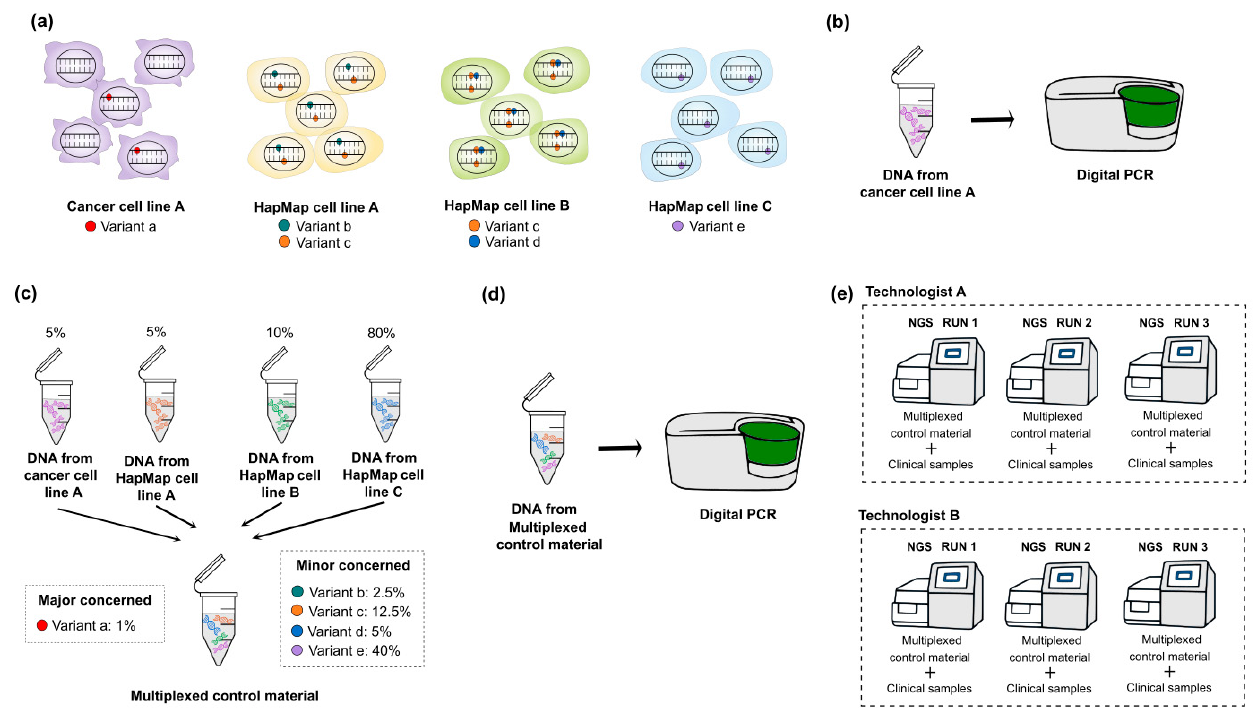
Figure 2. Schematic diagrams of developing multiplexed control materials to detect somatic variants. To multiplex HapMap and well-characterized cancer cell lines, following steps are necessary. ( a ) Selection of target genes and variants which are expected to be detected from both HapMap and cancer cell lines. In this step, major concerned variants (hotspot mutations) and minor concerned variants are defined by referring to the public database (e.g., GIAB for HapMap cell lines and COSMIC or CCLE for cancer cell lines). ( b ) Quantification for the allele frequency of major concerned variants in cancer cell lines by digital PCR. Before multiplexing cell lines, the quantification of the selected cancer cell lines is essential because the exact allele frequency of heterozygous variants in the cancer cell lines is unknown. ( c ) Multiplexing HapMap and cancer cell lines. To include the maximum number of minor concerned variants with various allele frequency ranges, the calculation for mixing ratio is necessary. ( d ) Quantification for the allele frequency of expected major concerned variants in developed multiplexed reference materials. ( e ) Establishing an answer set of detected variants with their VAF ranges and the list of variants that are presumed to be background errors through the repetition of NGS assay. Multiplexed reference materials should be sequenced with clinical samples. GIAB, Genome in a Bottle; COSMIC, Catalogue of Somatic Mutations in Cancer; CCLE, Cancer Cell Line Encyclopedia; VAF, variant allele frequency; NGS, next-generation sequencing.